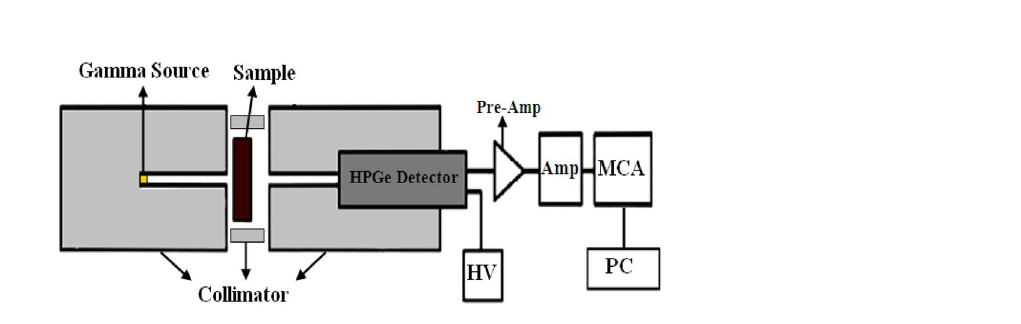
Figure 3. The arrangement of attenuation